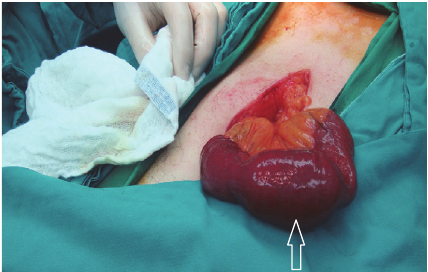
Figure 2: Intraoperative findings. Impacted proximal jejunal stone causing obstruction (white arrow).